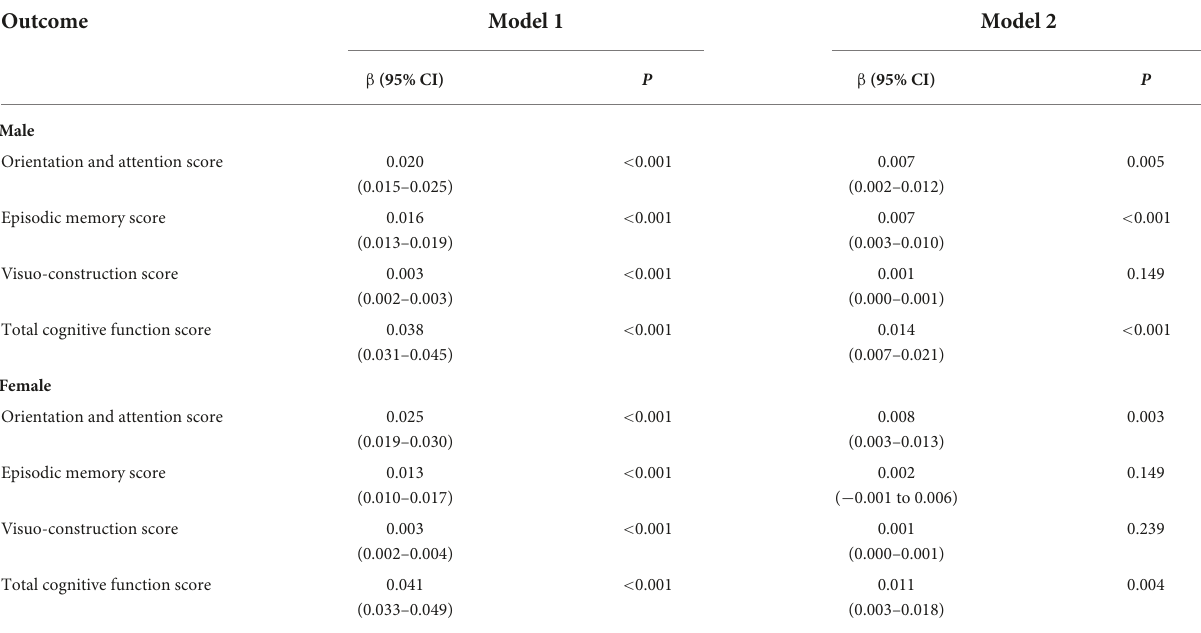
TABLE 3 Linear regression models for correlations between SI and cognitive function